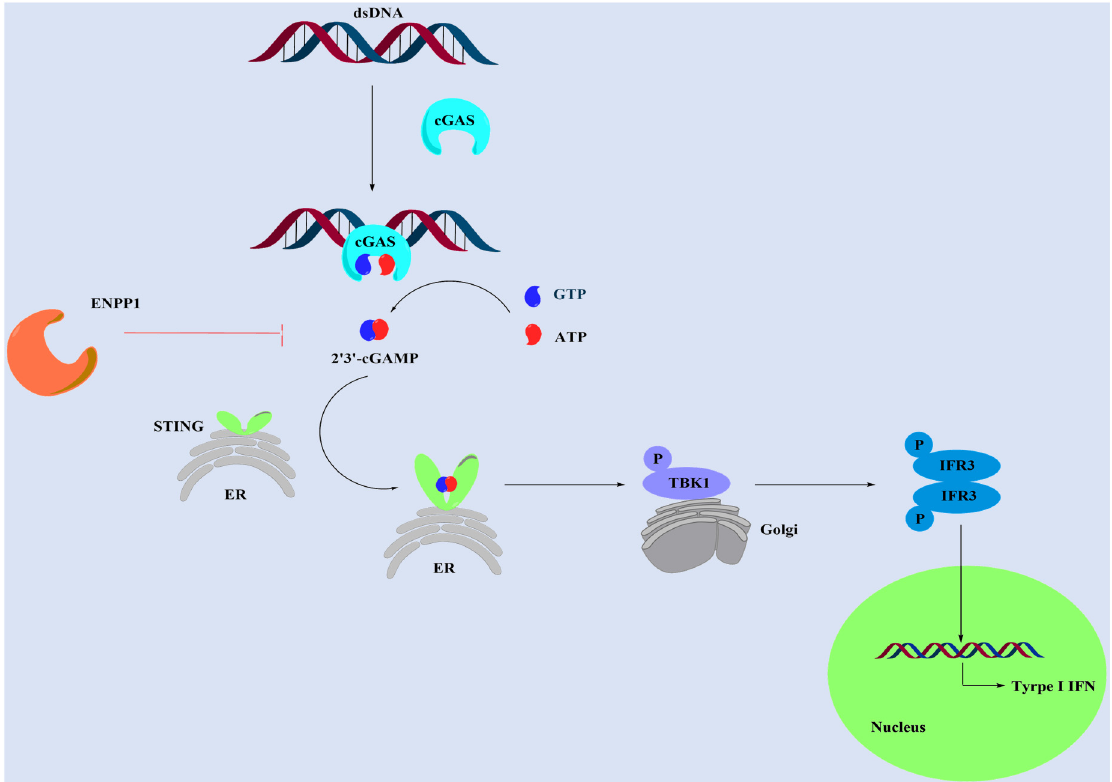
Figure 1. The cGAS ‒ STING ‒ TBK1-IFR3 signaling